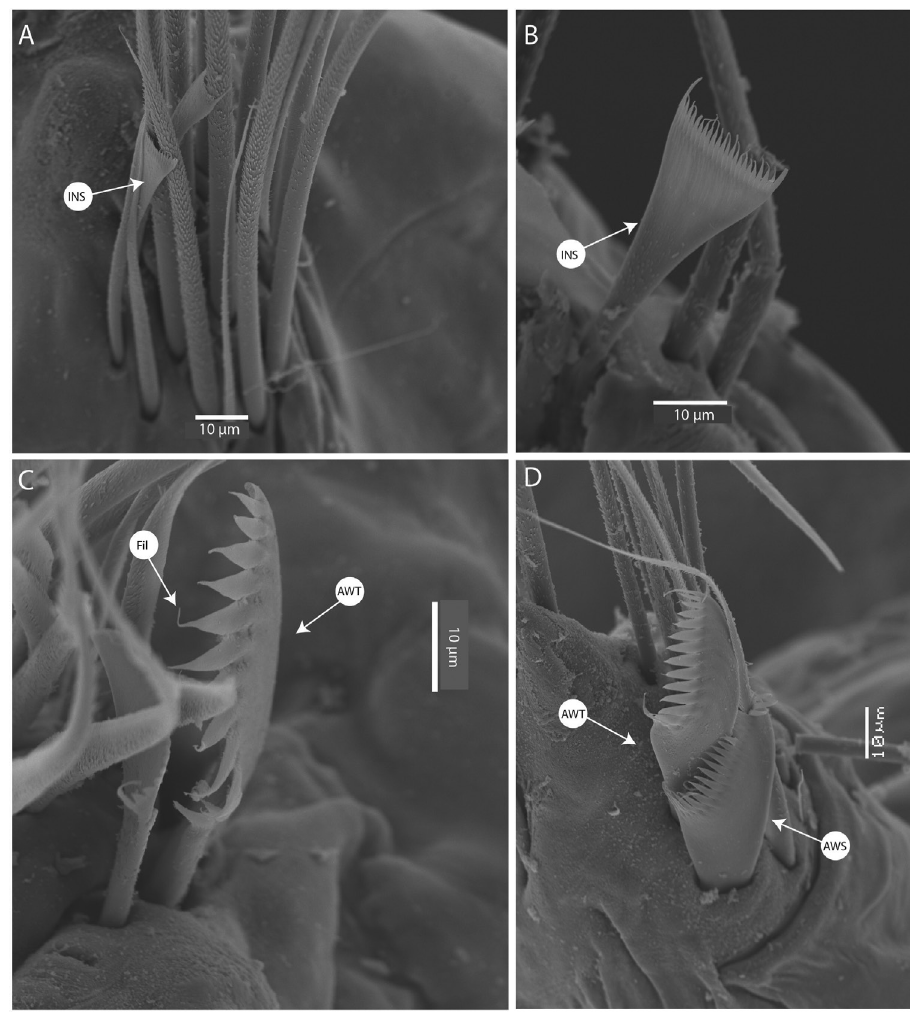
Figure 4. SEM images of pectinate chaetae of Marphysa banana sp. nov. paratype AM W.53774 A chaeti- ger 35 B chaetiger 67 C chaetiger 99 D chaetiger 131. Abbreviations: AWS, anodont-wide-slender; AWT, anodont-wide-thick; INS, isodont-narrow-slender; Fil,